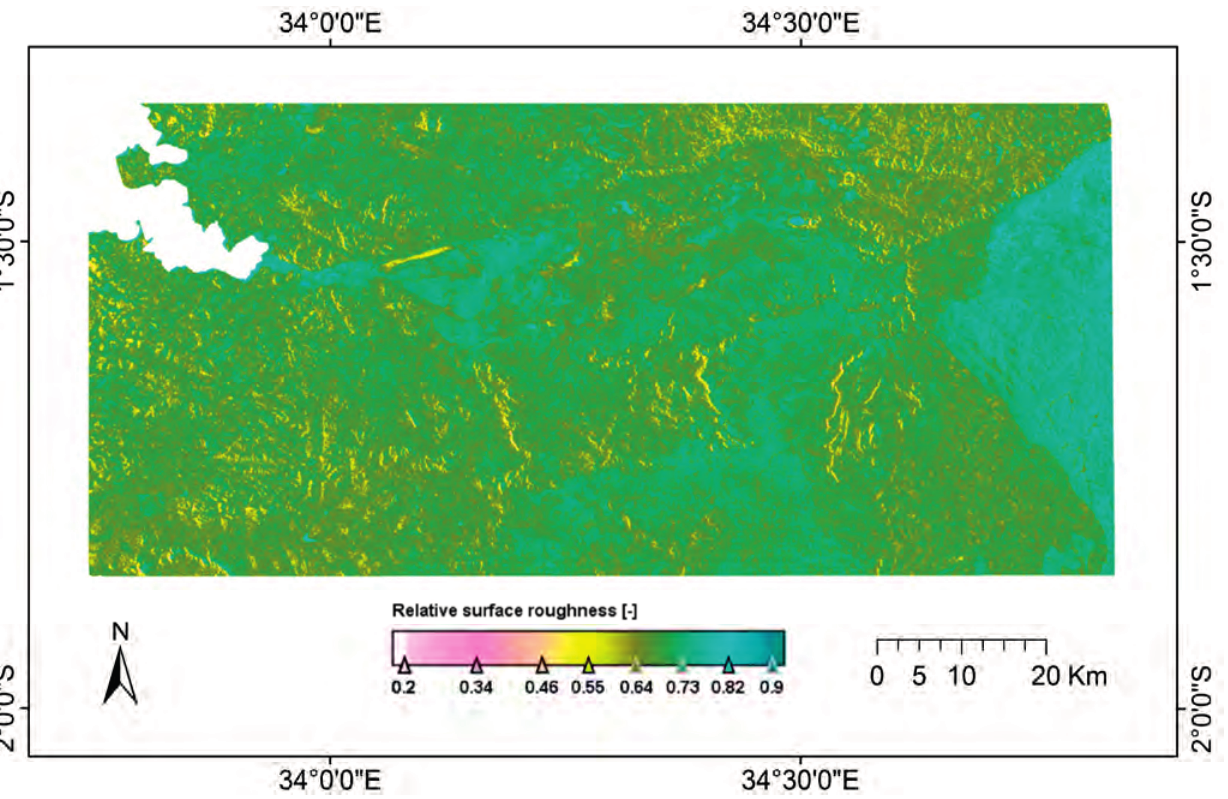
Figure 10. Relative surface roughness ( (cid:1837)